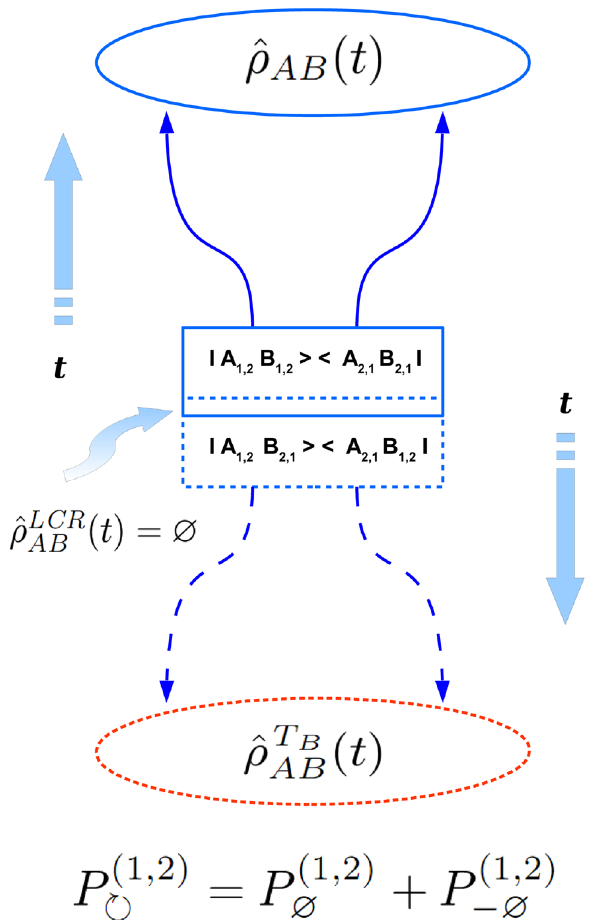
4 (two qubit- ) density matrix evolution in the entangled case with respect to Figure 2. Schematic picture of 4 × its partial transposition (pt-) procedure performed on B -subsystem taking into account two possible directions of a global time arrow in the entangled case. Square blocks are supposed to mark the moment of a given density t LCR 0 . It is shown that in the entangled case the pt- transformed density matrix matrix preparation at t = = 2 Hilbert space, involves virtual quantum transitions (projectors in the dashed block) being defined in the 2 ⊗ at the moment of its preparation. The latter projectors differ from those (projectors in the solid block) being responsible for the preparation of the original entangled density matrix as a whole. Hence, the partial transpose (pt-) transformation of the entire density matrix in one subsystem’s subspace automatically changes the way of quantum states preparation in the another subsystem(s) being entangled with the former. Since no local causality ∅ ρ LCR AB ( t ) reverse is possible in the entangled case in the entangled case one has ˆ =